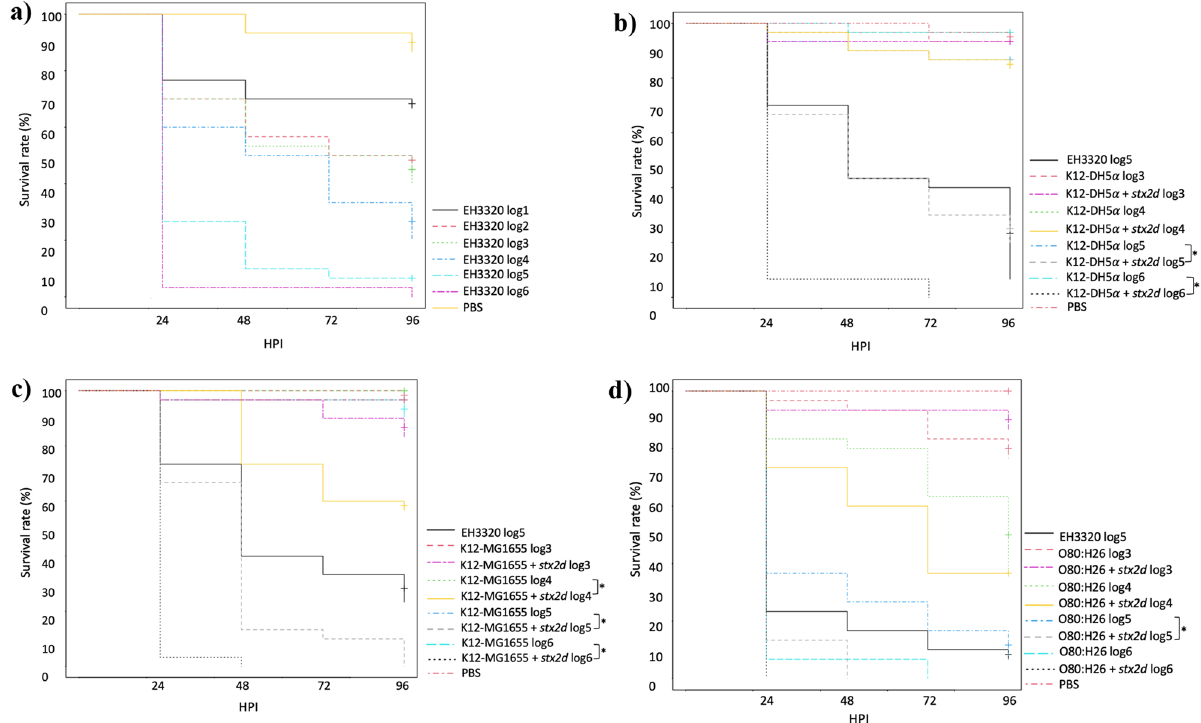
Figure 5. Kaplan–Meier survival curves of the experiments with G. mellonella larvae inoculated with ( a ) EH3320 at different concentrations ( b ) K12-DH5α with or without vB_EcoS_ULI-O80_Stx2d ( c ) K12-MG1655 with or without vB_EcoS_ULI-O80_Stx2d ( d ) O80:H26 with or without vB_EcoS_ULI-O80_Stx2d. Each group contained 30 larvae separated in three groups of 10 larvae. HPI hours post inoculation. * p <